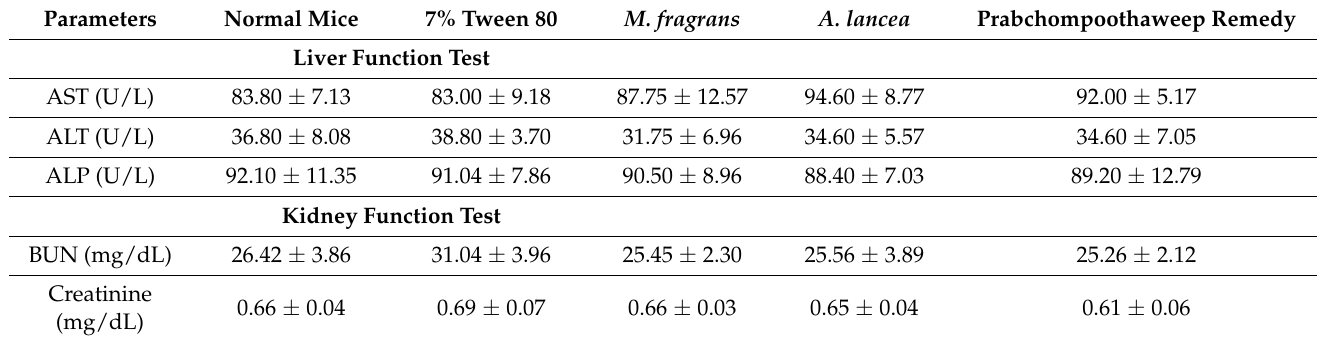
Table 9. Effect of ethanolic extracts of M. fragrans , A. lancea , and Prabchompoothaweep remedy on kidney and liver functions in the acute toxicity test.